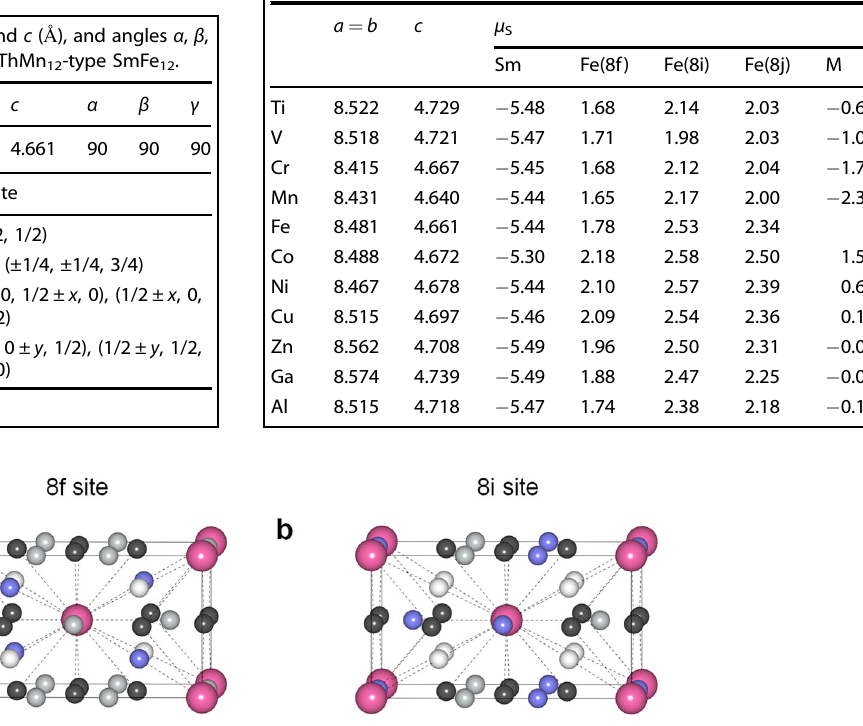
Table 2. Optimized lattice parameters a , b , and c ( Å ), and